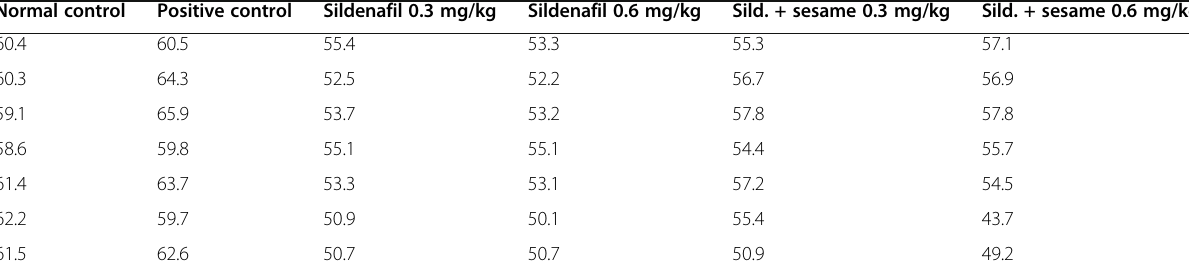
Table 1 Effect of sesame intake on sperm count of prolonged sildenafil-administered adult male rats Normal control